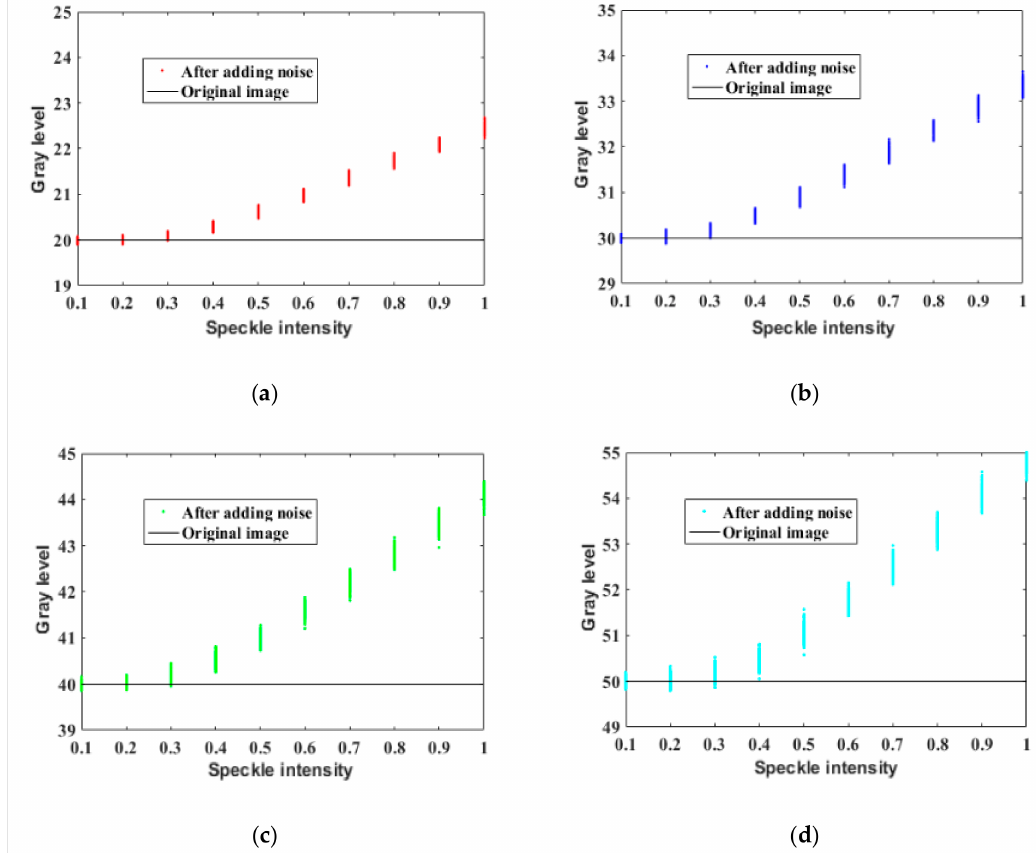
Figure 4. Influence of speckle noise on image gray values: ( a ) Gray value of 20; ( b ) gray value of 30; ( c ) gray value of 40; ( d ) gray value of